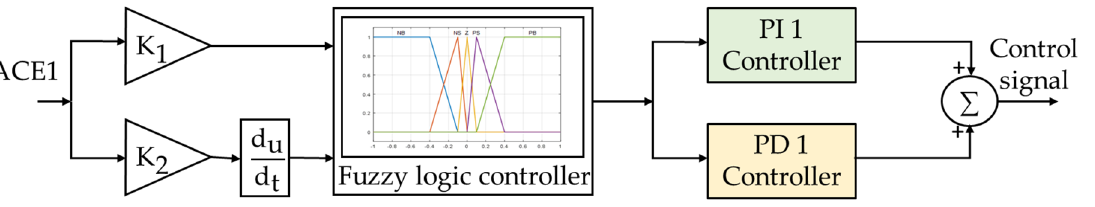
Figure 17. Block diagram of Fuzzy PI plus Fuzzy PD controller configuration equipped in area one.